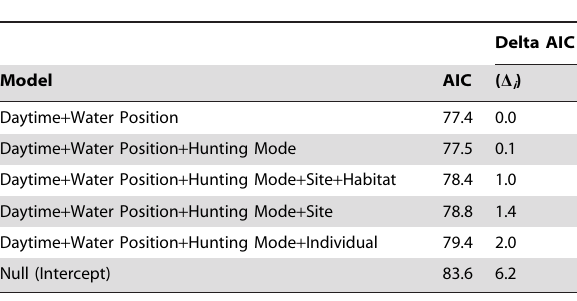
Table 3. AIC values for logistical GLMs, predicting the probability of prey-capture